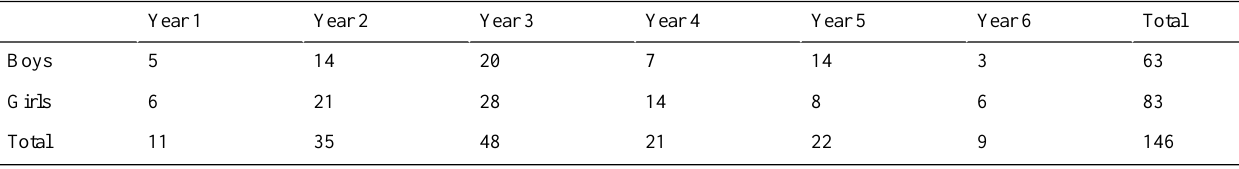
Table 1. Number of language evaluations conducted by age and